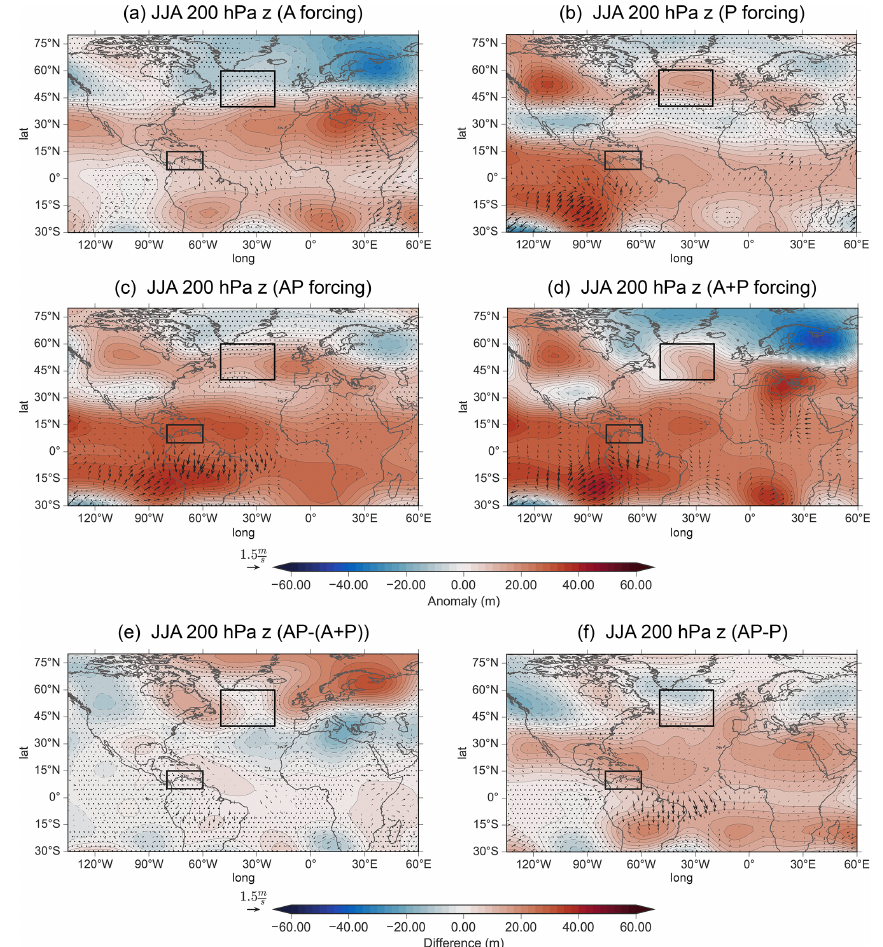
Figure 10. Same as Fig. 9 but for